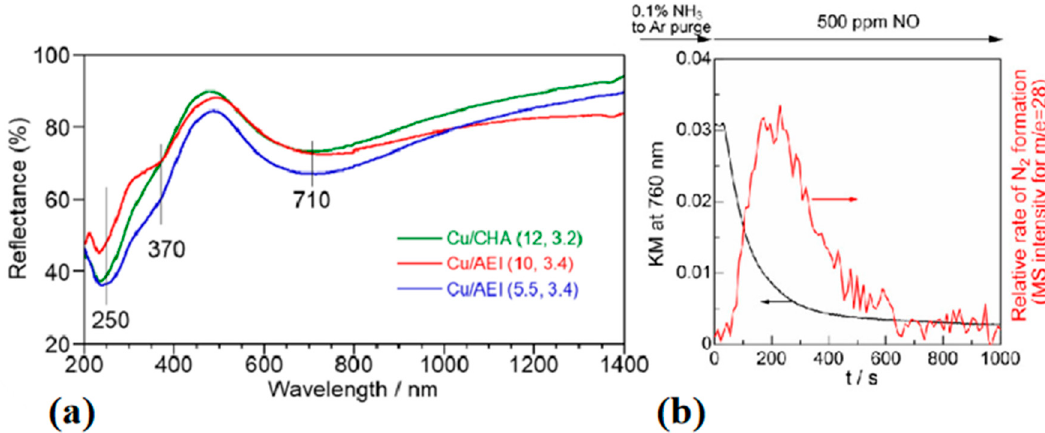
Figure 7. ( a ) In situ diffuse reflection ultraviolet-visible spectroscopy (DRUVS)-NIR spectra of Cu/CHA (12 and 3.2), Cu/AEI (10 and 3.4), and Cu/AEI (5.5 and 3.4) samples under a mixture of 1000 ppm of NO, 1000 ppm of NH 3 , and 10% O 2 gas at 473 K: reproduced with permission from [94], copyright American Chemical Society, 2020. ( b ) In situ DRUVS spectra of Cu-CHA at 200 °C: the catalyst was first oxidized under 10% O 2 /Ar (100 mL min − 1 ), followed by exposure to 0.1% NH 3 /Ar flow (100 mL min − 1 ) for 0.5 h and then to 500 ppm NO/Ar flow (100 mL min − 1 ). Reproduced with permission from [96], copyright ChemCatChem, 2020.